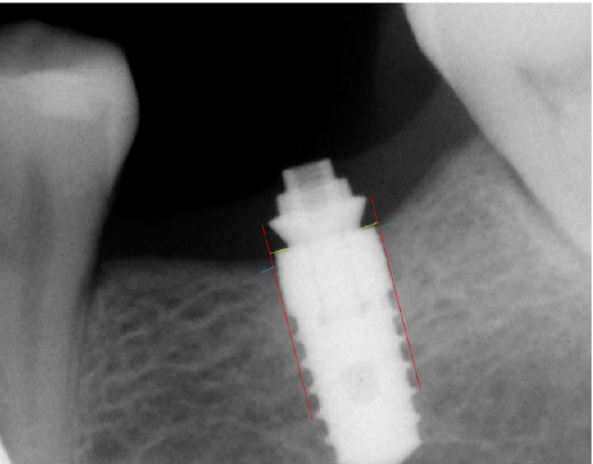
Figure 4. The distance between the implant shoulder and the first bone to implant contact in mesial and distal was used to measure bone level variation throughout time. In yellow: implant platform. In blue: first visible bone contact.